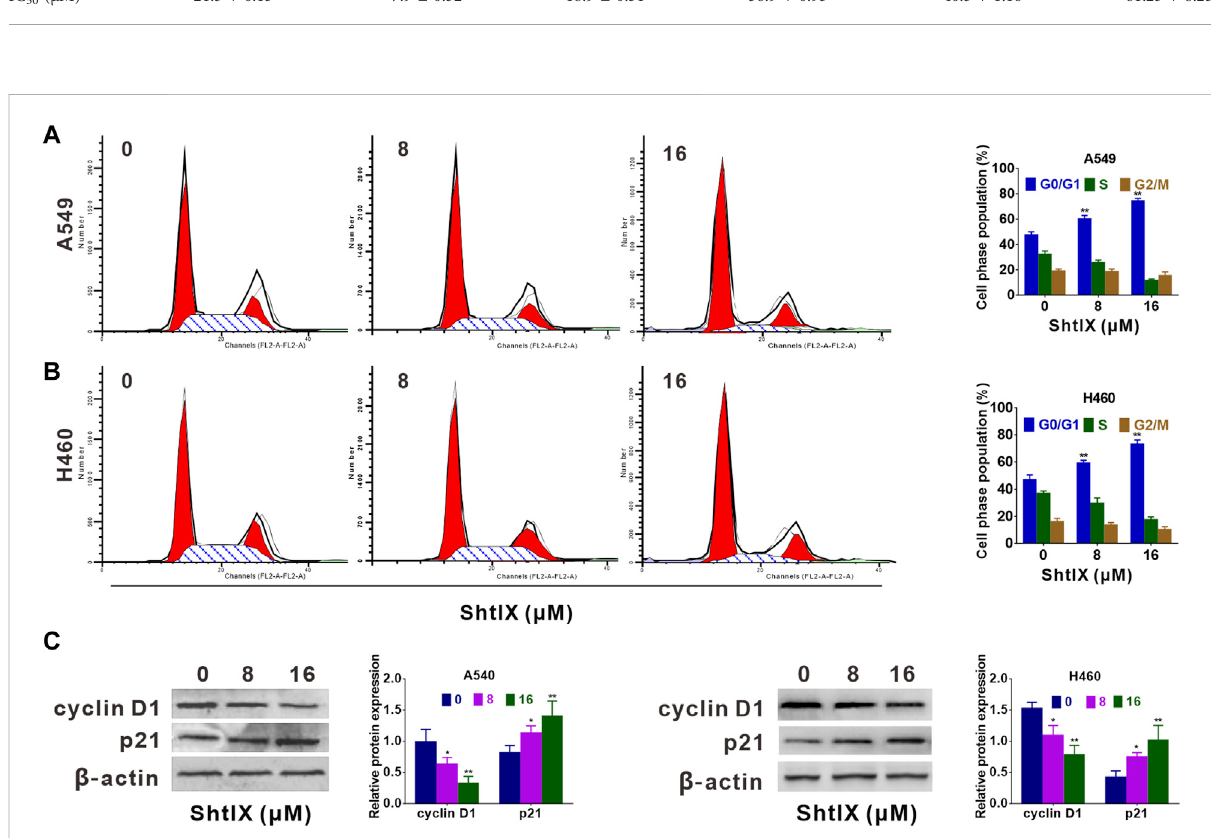
FIGURE 2 ShtIX inhibited cell cycle progression in NSCLC cells. Cells were exposed to speci fi ed concentrations of ShtIX for 24 h, and then were analyzed by PI staining. (A,B) DNA content was analyzed by fl ow cytometry. (C) Cell cycle related-proteins were determined by western blot. Data were presented as the mean ± SD of three independent experiments. * p < 0.05, ** p <